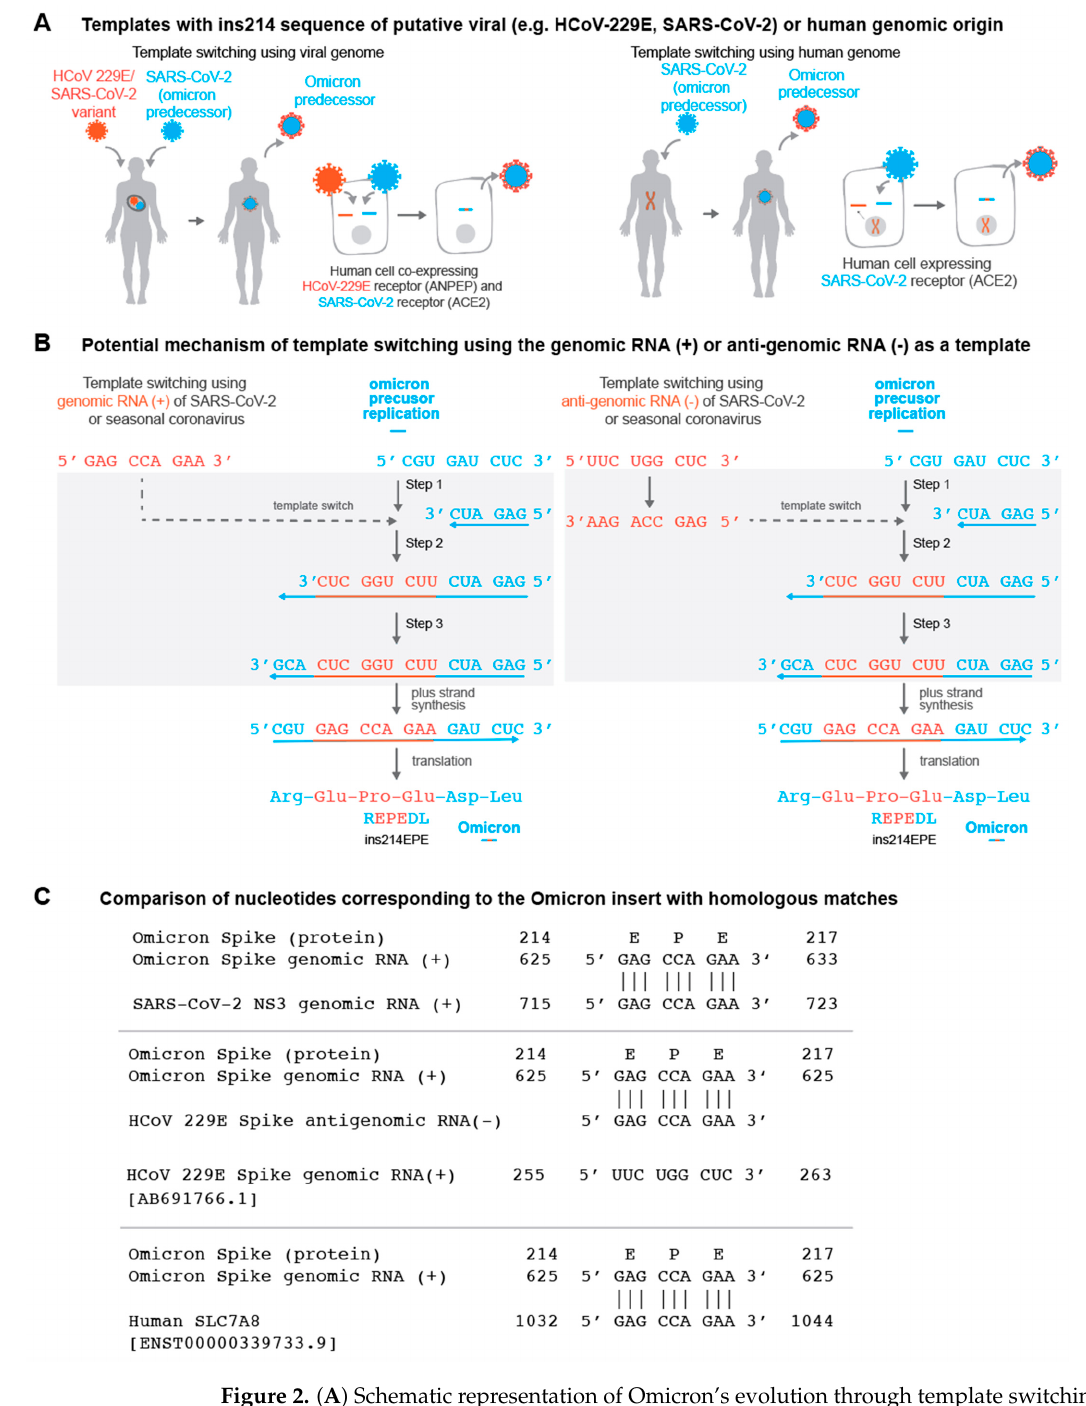
Figure 2. ( A ) Schematic representation of Omicron’s evolution through template switching involving viral (e.g., seasonal coronavirus or SARS-CoV-2) or human RNA. ( B ) Potential mechanism of template switching using viral genomic RNA (positive sense) or anti-genomic RNA (negative sense) as a template. Step 1: Negative-strand synthesis begins using an Omicron predecessor’s genomic RNA as template. Step 2: Negative-strand synthesis temporarily uses the genomic or anti-genomic RNA of SARS-CoV-2 or a co-infecting virus. Step 3: Negative-strand synthesis resumes using the Omicron predecessor’s genomic RNA as template. ( C ) Examples of matches identical to the nucleotide sequence “GAG CCA GAA” in the SARS-CoV-2 genome, the HCoV-229E anti-genome, and a human SLC7A8 transcript are